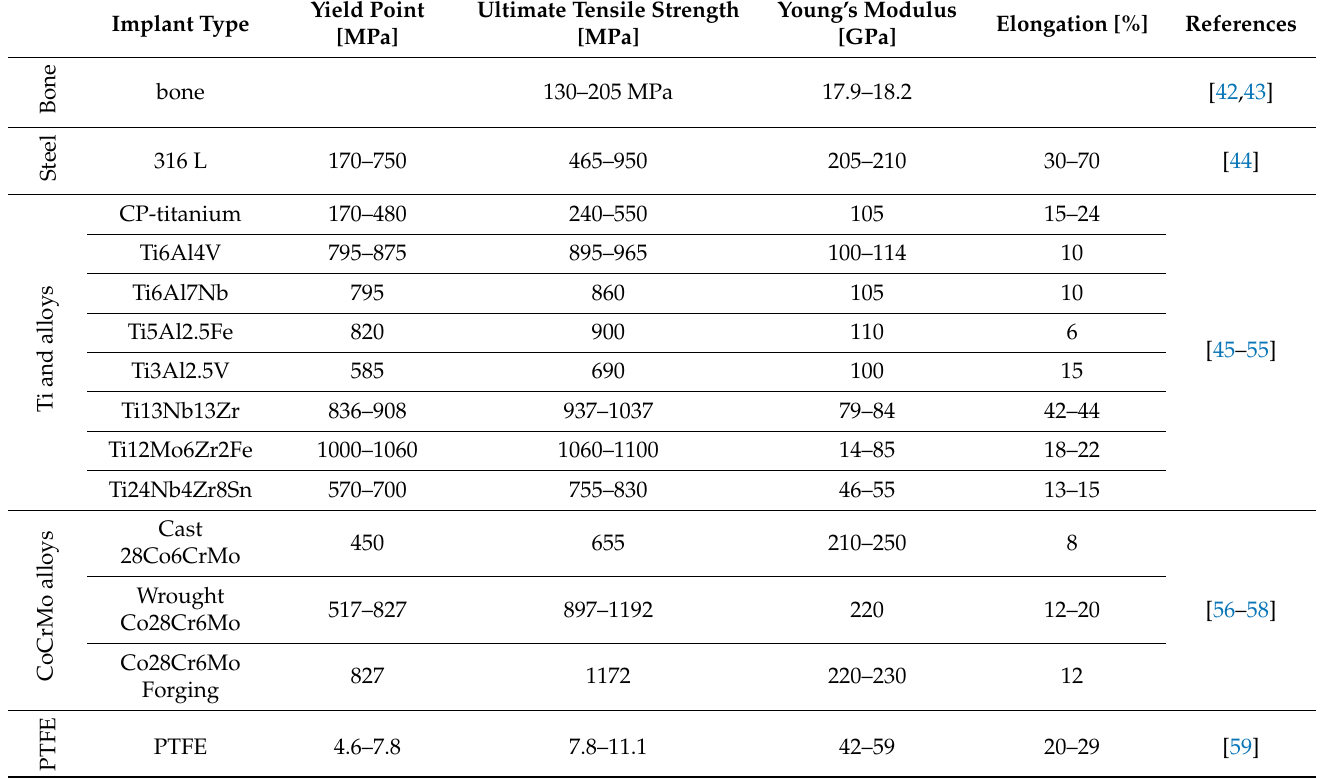
Table 1. Physical characteristics of bone, PTFE, and most the extensively used orthopaedic surgery alloys. Implant